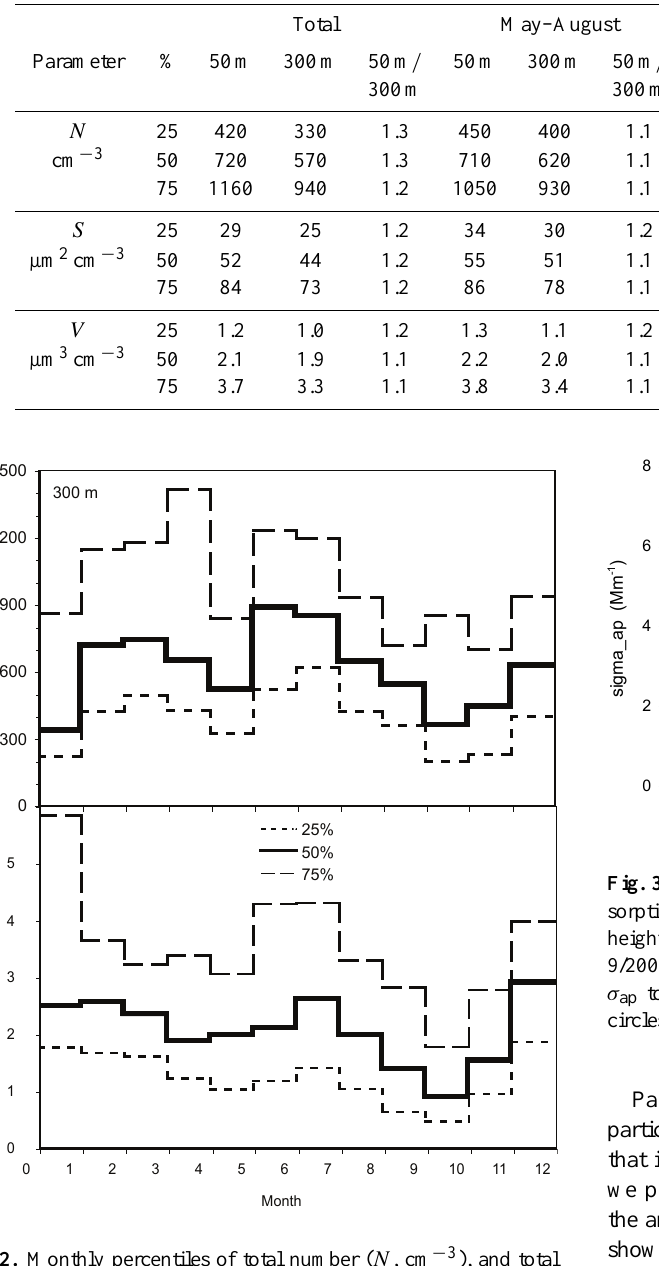
Fig. 2. Monthly percentiles of total number ( N , cm − 3 ), and total volume ( V , µm 3 cm − 3 ) in 300m height at ZOTTO, Siberia for the period 9/2006–1/2010.